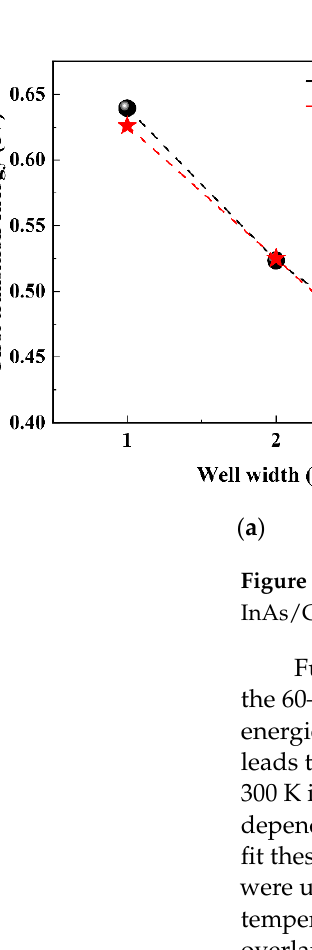
Figure 7. Theoretical and experimental results of first transition energies for 1, 2, and 3 MLs of InAs/GaSb MQW for ( a ) 300 K and ( b ) 77 K.